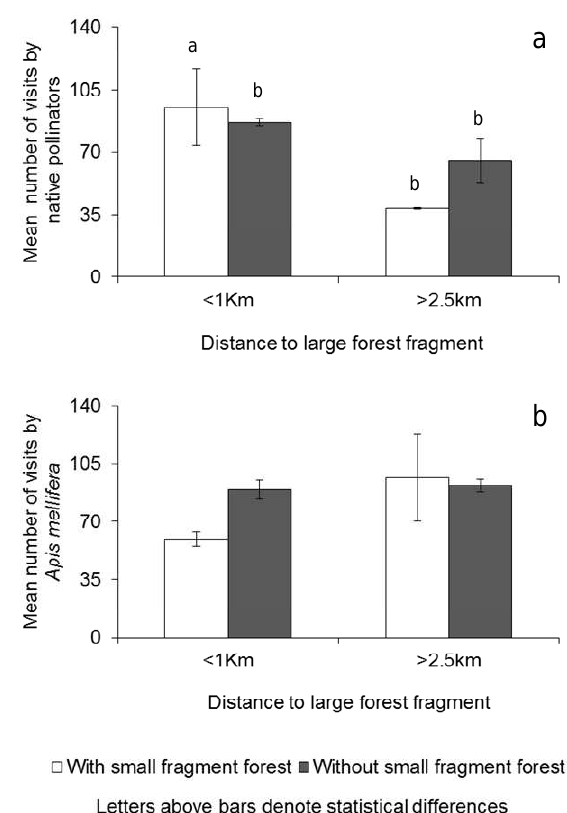
F IGURE 4. Effect of the distance (m) between cashew ( Anacardium occidentale ) plantations and a large (> 100ha) forest fragment on the mean number of honeybees ( Apis mellifera ) and native wild pollinators visiting flowers in the state of Ceará, Brazil.